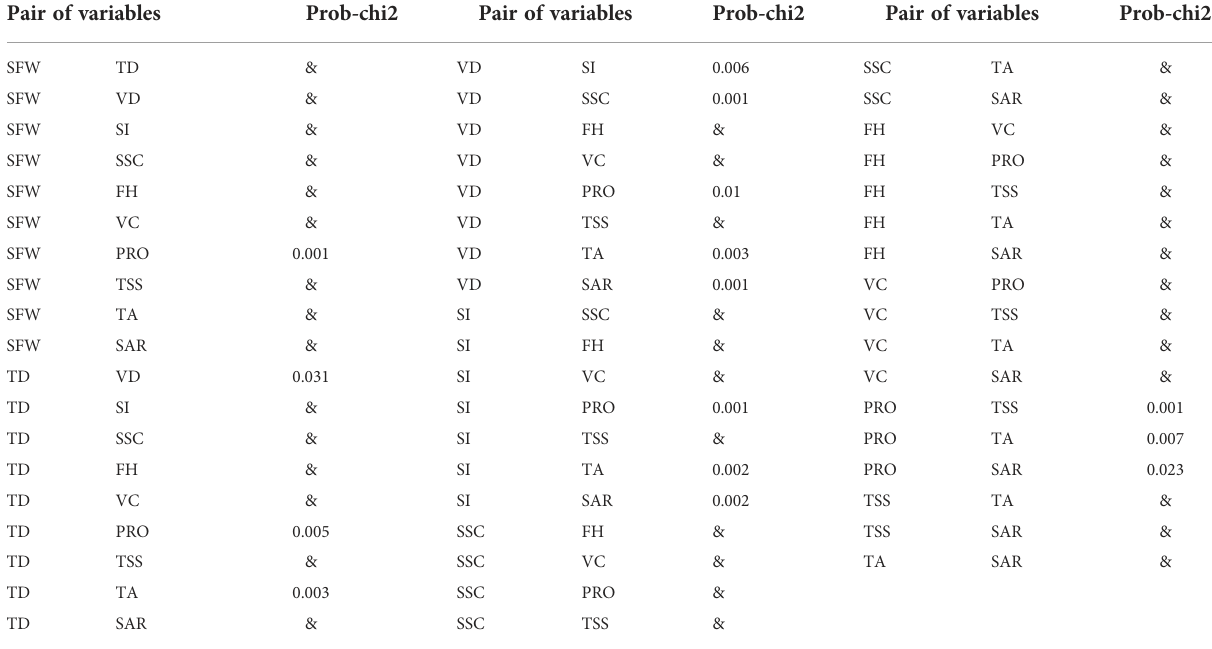
TABLE 2 Doornik-Hansen bivariate normality test for fruit quality